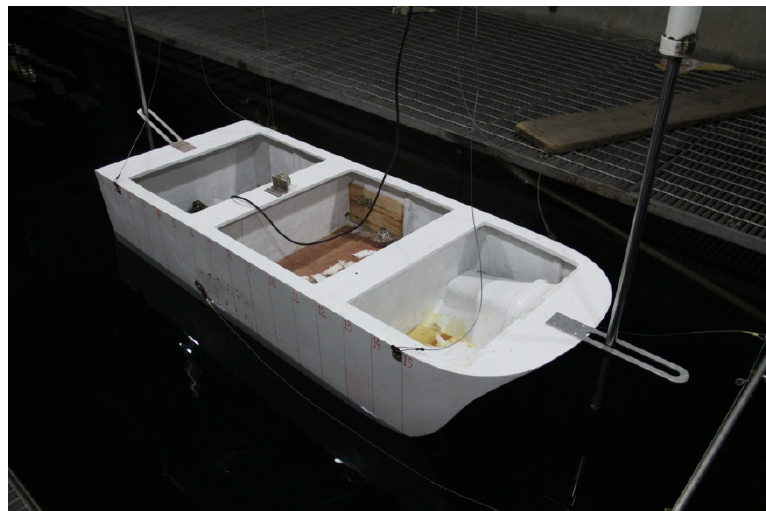
Figure 3. Planing trimaran model test installation diagram.